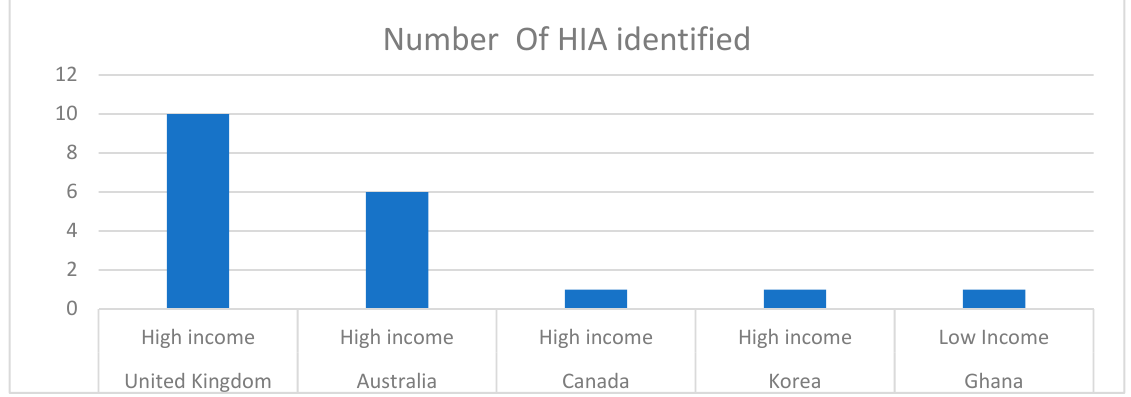
Table 2. Setting for HIAs.